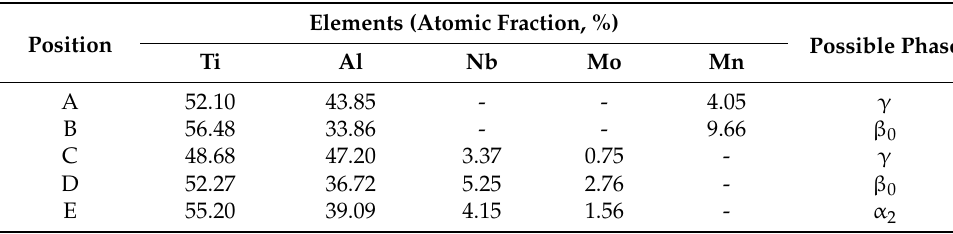
Table 2. Compositions at different positions in Figure 4 identified by EDS.